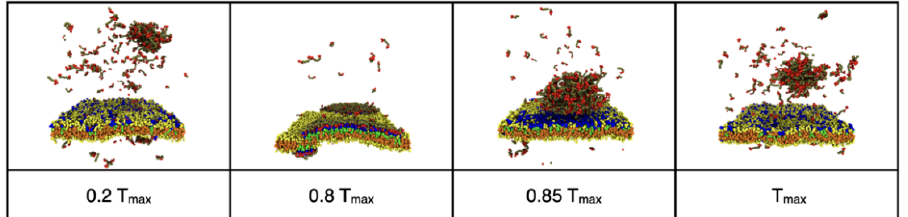
Figure 9. Reversible dissolution of the bulk IDP droplet and wetting of the membrane induced by toggling the interaction of the endcaps (red beads) with the minority phase lipid headgroups (blue beads.).